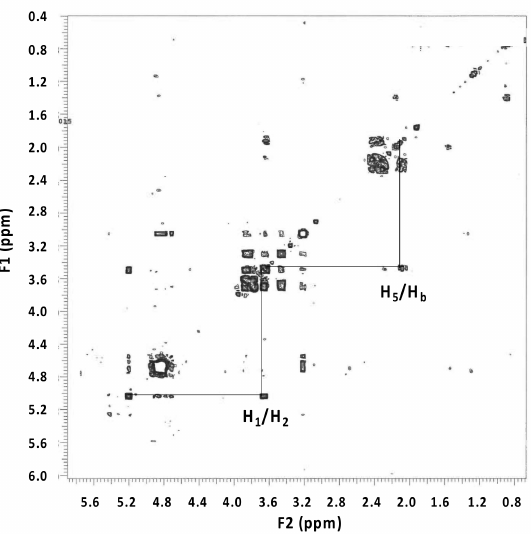
Figure 4. Gradient COSY spectrum illustrating the coupling between the proton attached to the anomeric carbon and the adjacent proton on the pyranose ring as well as the coupling between the pyranose ring proton at d 3.62 and the proton at d